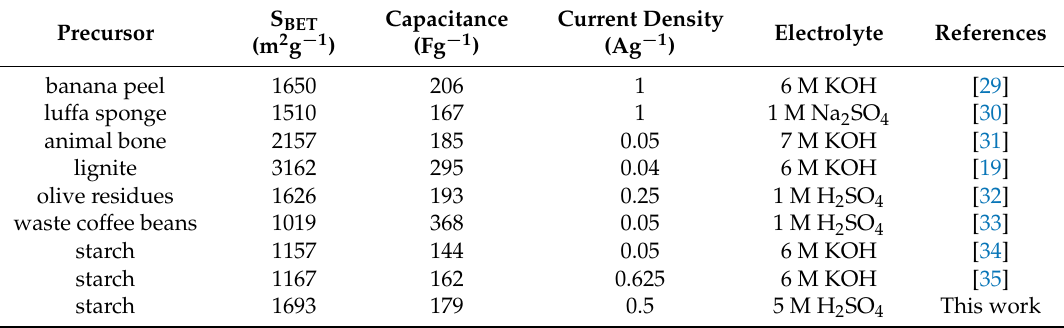
Table 1. Comparison of previously reported carbonaceous materials for